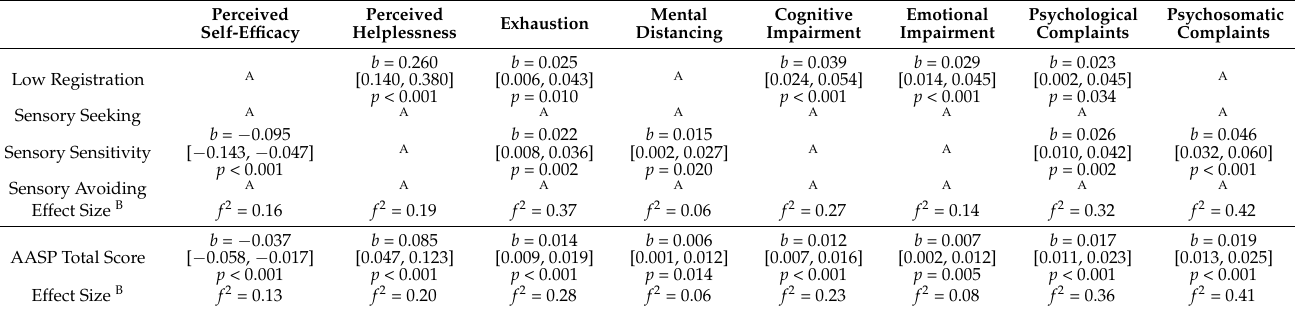
Table 4. Multiple regression models with AASP raw quadrant and total scores, and stress- and burnout-related subscale scores.